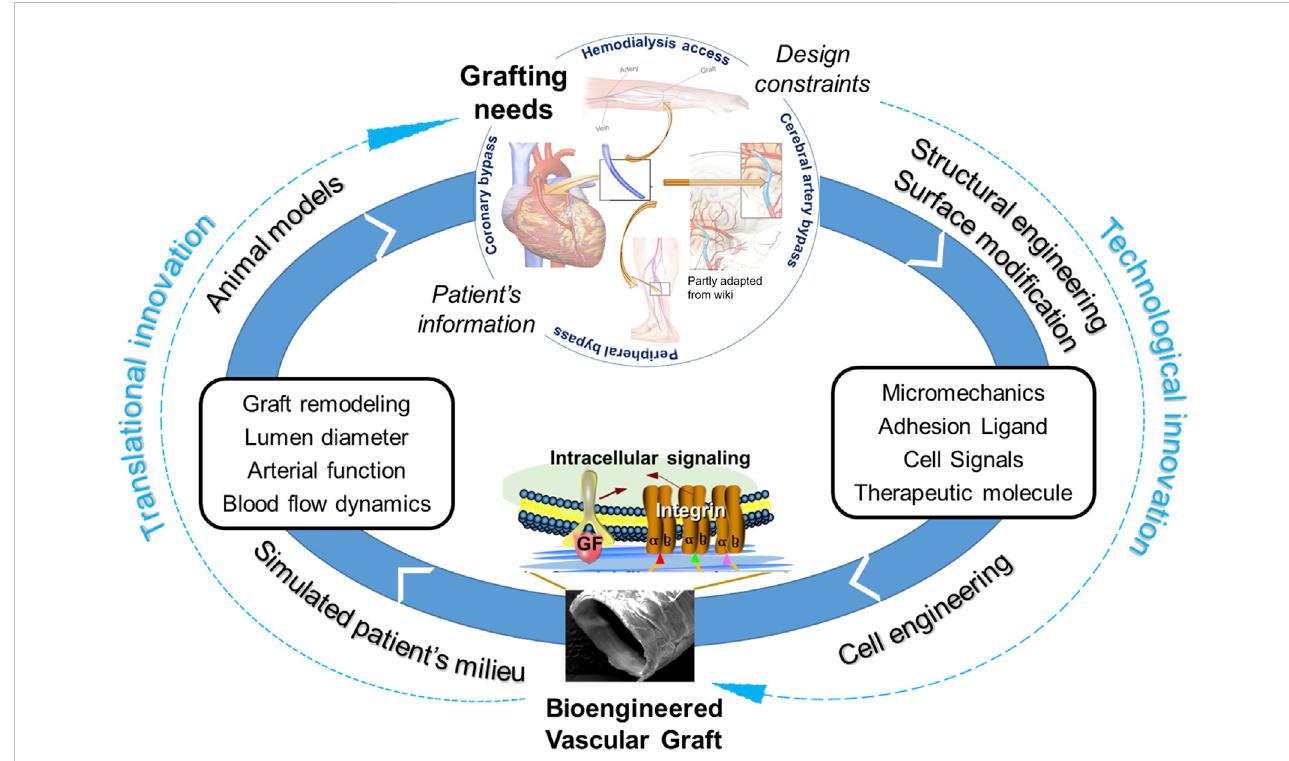
FIGURE 6 Coupling of technological innovations with translational innovations to tackle adverse remodeling of vascular grafts for clinical applications.